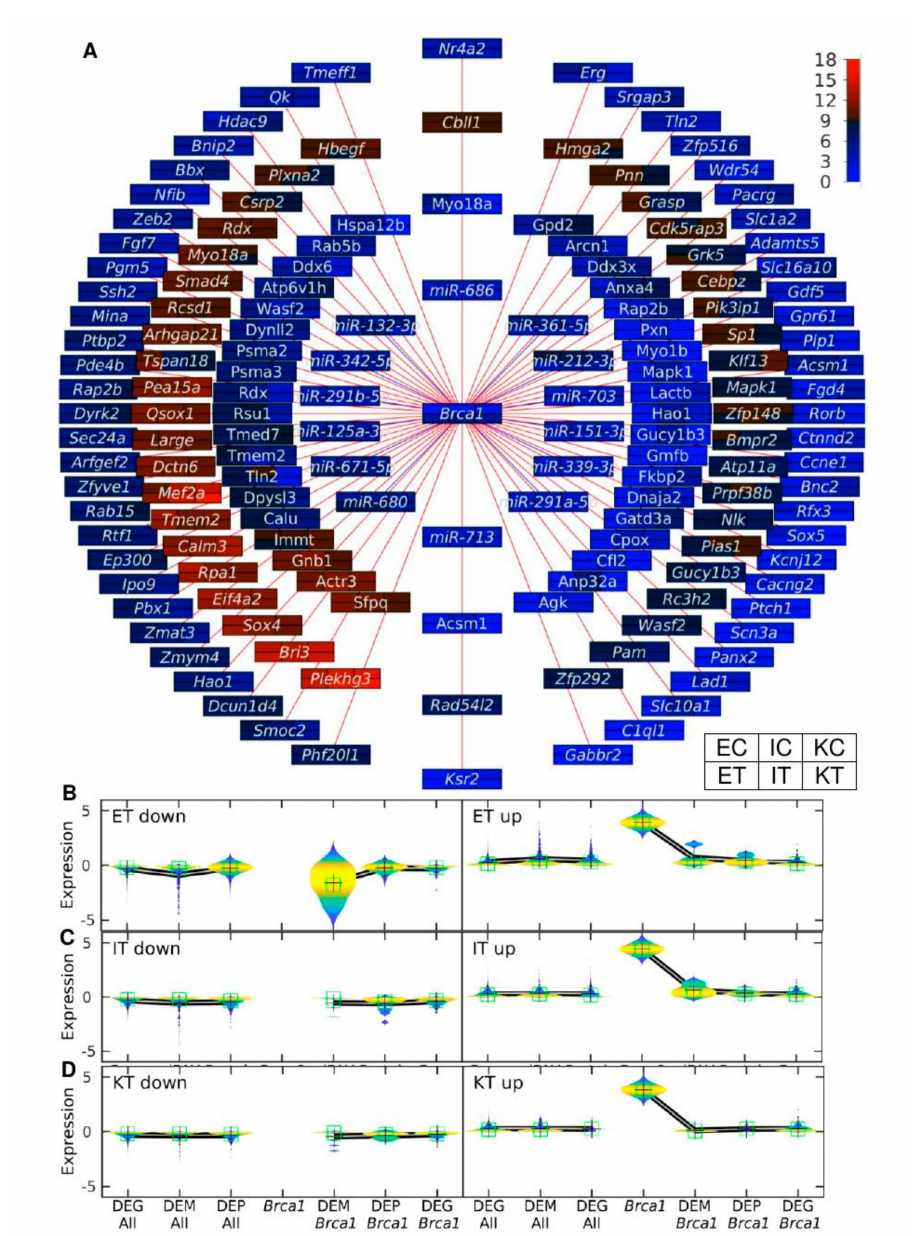
Figure 5. Proposed gene-miRNA-protein network centered in Brca1 . ( A ) The network center is the gene expression level of Brca1 . The concentric rings from the center towards the periphery present the expression level of the miRNAs targeting Brca1 , the protein level of the proteins targeted by such miRNAs, and the expression level of the genes targeted by such miRNAs (the last ring is double), respectively. Each molecule (gene, miRNA, protein) is represented by a rectangle with six colors codifying the expression of the samples in the order given by the legend frame. Higher gene expression corresponds to redder color. Violin plots in endothelial ( B ), Ito ( C ), and Kup ff er ( D ) of the distribution of the down- and up-regulated molecules in tumor vs. the control of DEGs, DEMs, and DEPs in all the data and in Brca1 , miRNA targeting Brca1 , in proteins, and in genes targeted by such miRNAs. For each mRNA sample, we used 4 biological replicates; for each miRNA sample, 3 biological replicates, except 2 for ECs and KTs; for the proteomics data, 9 biological replicates for ECs, 7 for ETs, 6 for ICs and ITs, and 5 for KCs and